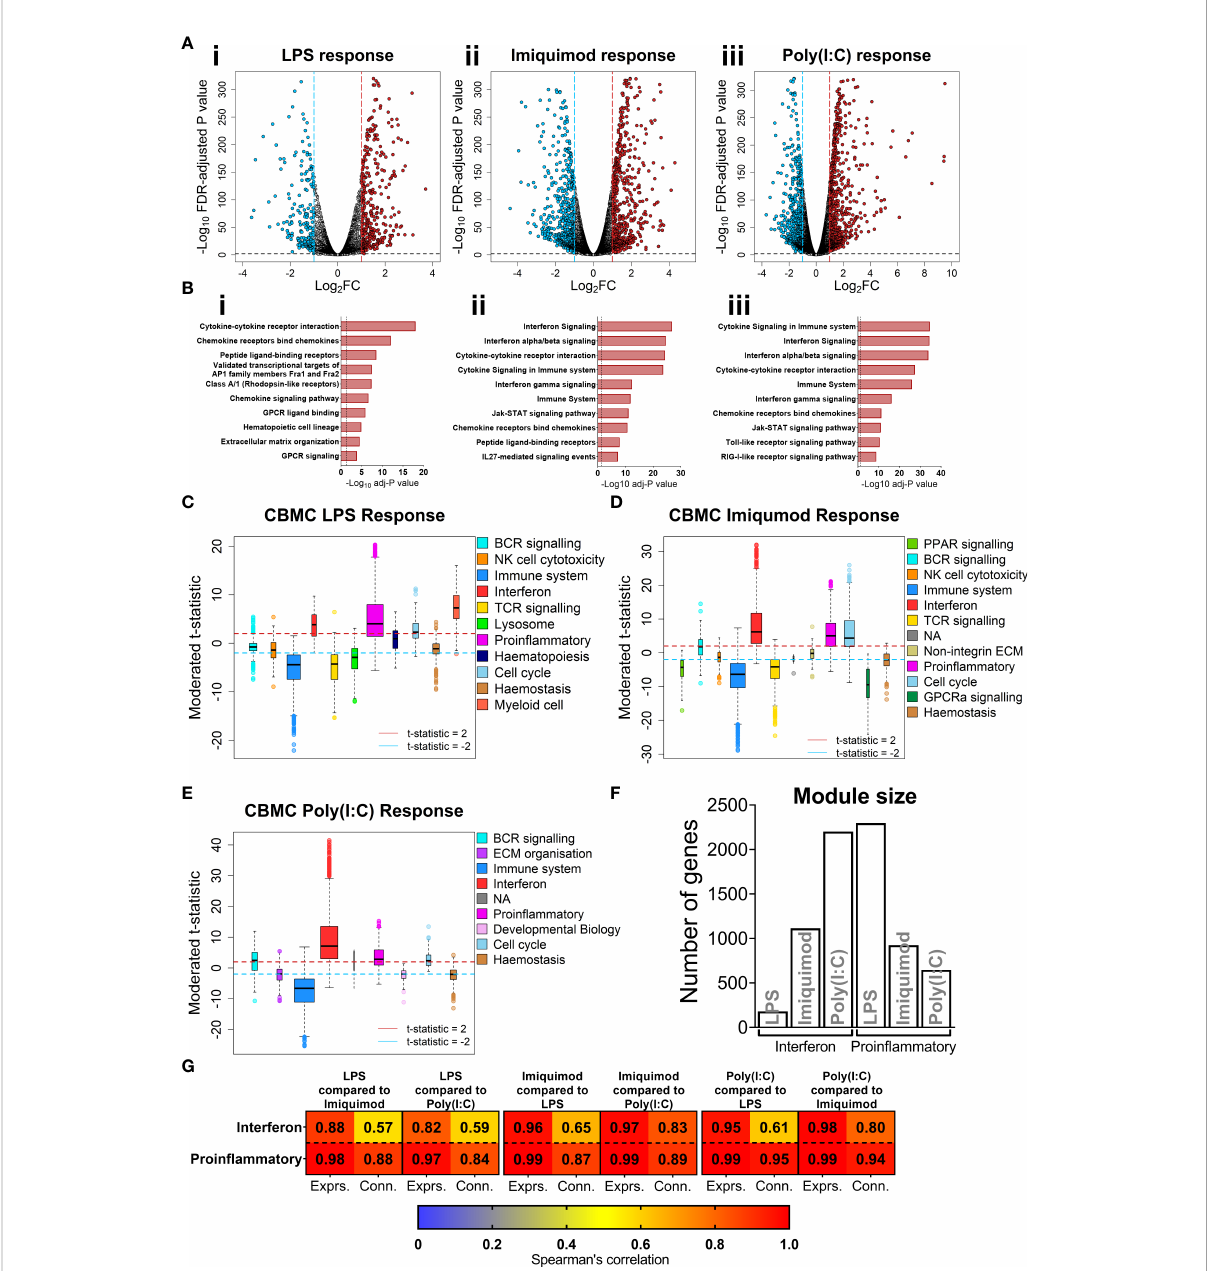
FIGURE 2 IFN and proin fl ammatory gene expression following TLRs 3/4/7 activation in CBMC. (A) Volcano plot showing signi fi cantly upregulated (red) and downregulated (blue) genes compared to matched unstimulated samples for the LPS (i), Imiquimod (ii), and Poly(I:C) (iii) responses, respectively. Plots show the Log 2 fold-change (x-axis) and FDR-adjusted p value (-Log 10 transformed). Blue and red dashed lines indicate a Log 2 FC of -1 and 1, respectively; black dashed line denotes a -Log 10 FDR-adjusted p value of 2. (B) Top 10 overrepresented pathways from signi fi cantly upregulated genes of the CBMC LPS (i), Imiquimod (ii), and Poly(I:C) (iii) responses. X-axis shows the FDR corrected p value (-Log 10 transformed); black dashed line indicated corrected p ≈ 0.05. (C – E) Modules identi fi ed from network analysis (WGCNA) of the LPS, Imiquimod, and Poly(I:C) responses, respectively. Modules are plotted by moderated t-statistics (y-axis) and show the median, 25 th and 75 th quartiles ±1.5xIQR and outliers. Modules with medians above the red line (moderated t-statistic = 2) are considered signi fi cantly upregulated and those below the blue line (-2) are considered signi fi cantly downregulated. (F) Bar plot of the number of genes in the interferon and proin fl ammatory modules for the respective responses. (G) Heatmap showing Spearman ’ s correlation values of ranked expression and ranked connectivity between CBMC response module genes. Expression of member genes from the IFN and proin fl ammatory modules of each response were correlated against the expression of the same genes from the other responses. The p value associated with all correlations was <